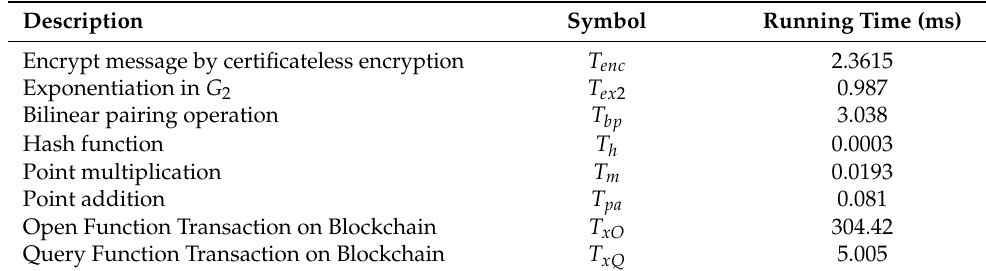
Table 1. Cryptographic operations running times.